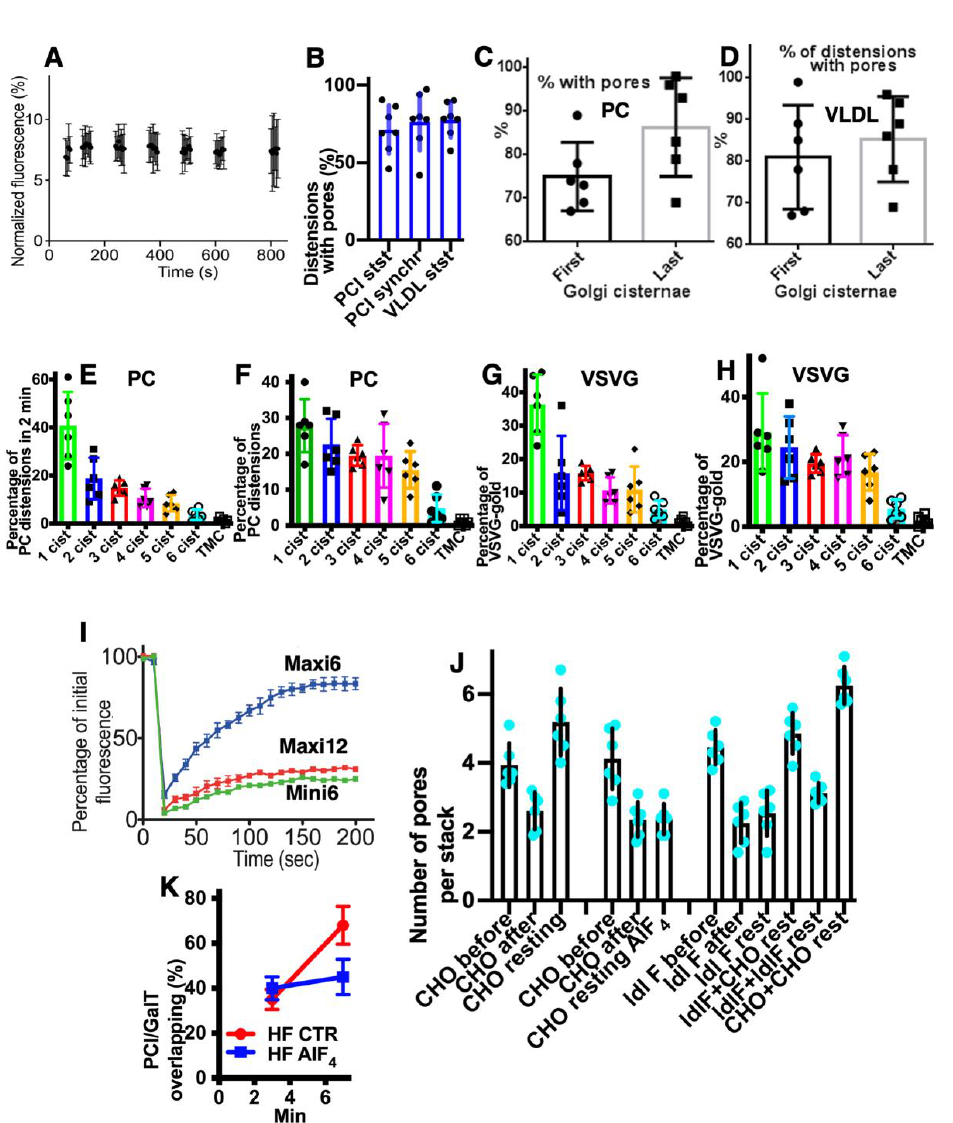
Figure 7. Quantification of the results. ( A ). Fluorescence intensity of VSVG dots does not change during intra-Golgi transport. ( B ) Proportion of PCI and VLDL distensions separated with the pore row is high. ( C , D ) Proportions of cisternal distensions surrounded with pores. Pores surround cisternal distensions with PCI ( C ) and VLDL ( D ) in both the first and last Golgi cisternae. ( E – H ) Distribution of gold labelling for PC distensions ( E , F ) and VSVG ( G , H ) at 2 min after release of transport block, according to the mini-wave ( E , G ) and maxi-wave ( F , H ) protocols. Labelling densities of gold and distensions in the first medial cisterna in ( E , G ) are significantly higher than in the last medial cisterna ( p < 0.05), whereas this difference is less in ( F , H ). ( I ) Fluorescence recovery (dynamics of the ratio between fluorescence intensity between the bleached zone and ER). Synchronisation protocols and times after the release of the temperature blocks are indicated in the images. After the maxi-wave synchronisation, the recovery is greater at 6 min than those during the mini-wave and at 12 min after release using the maxi-wave. ( I , J ) Inhibition of the COPI function decreases the rate of pore restoration decrease. In CHO and ldlF cells, the COPI function was inhibited by heating cells to 40 ◦ C for 2 min. In CHO cells, the bar after is lower than the bar resting. In ldlF cells, this difference is not significant. In heterokaryons composed of CHO cells, the restoration is high. In the heterokaryons composed of ldlF cells, it remains low. In heterokaryons composed of CHO and ldlF cells, the speed of the pore restoration is higher than in ldlF cells. ( K ) During intra-Golgi transport, co-localisation between PCI and GalT increases in control (CTR) cells but is inhibited in cells treated with AlF 4